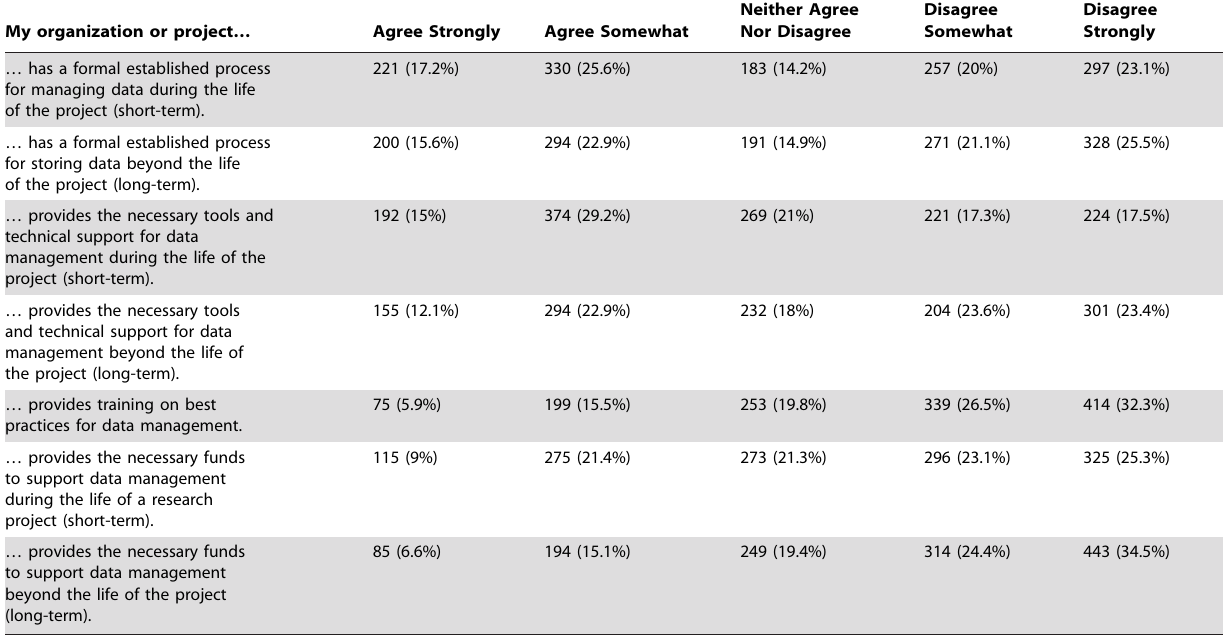
Table 7. Organizational involvement in data issues.